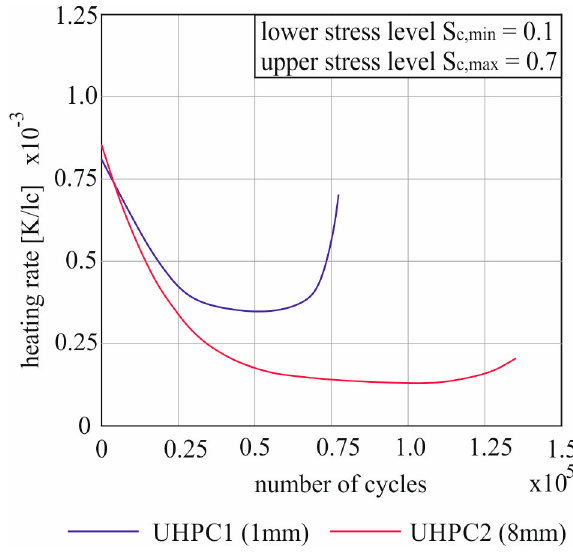
Figure 9. Comparison of the Heating rate of UHPC 1 and UHPC 2 specimens for test frequency f P = 10 Hz and relation between lower and upper stress level S c,min / S c,max = 0.1 / 0.7. The heating rate is related to the load cycles (lc).